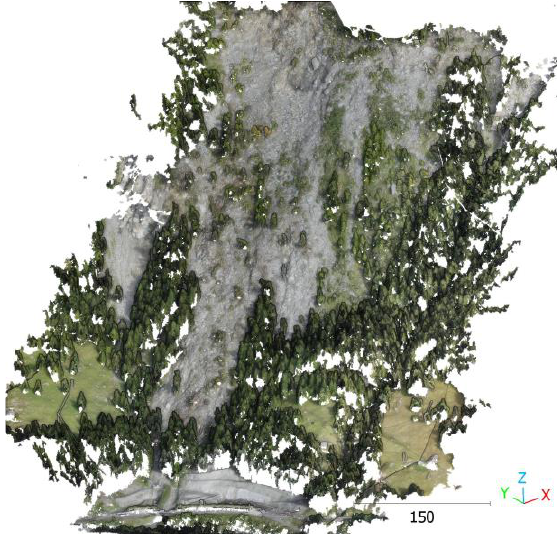
Figure 12. September 2019 point cloud.